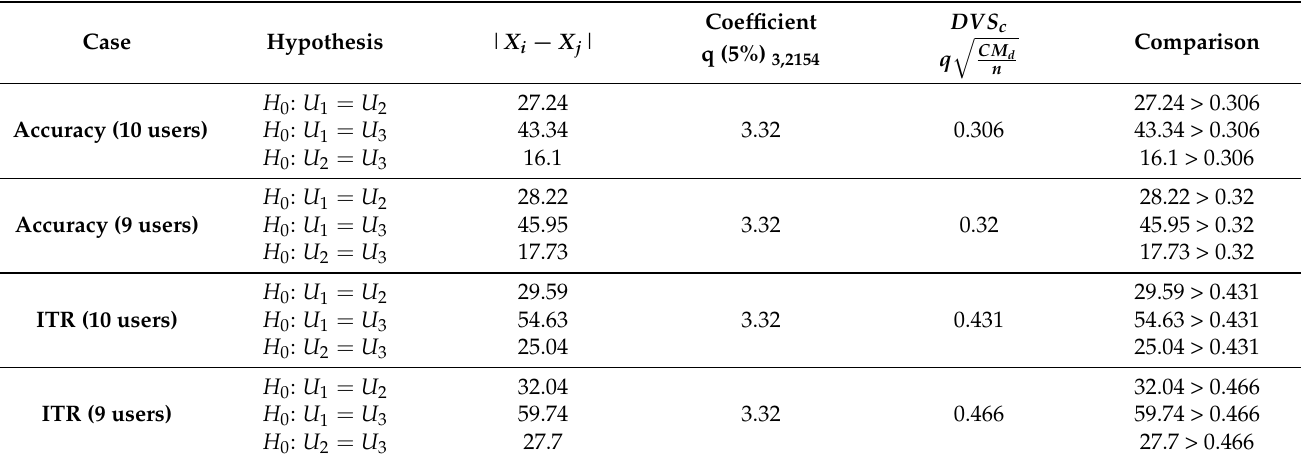
Table 4. Post-Tukey’s test for Accuracy